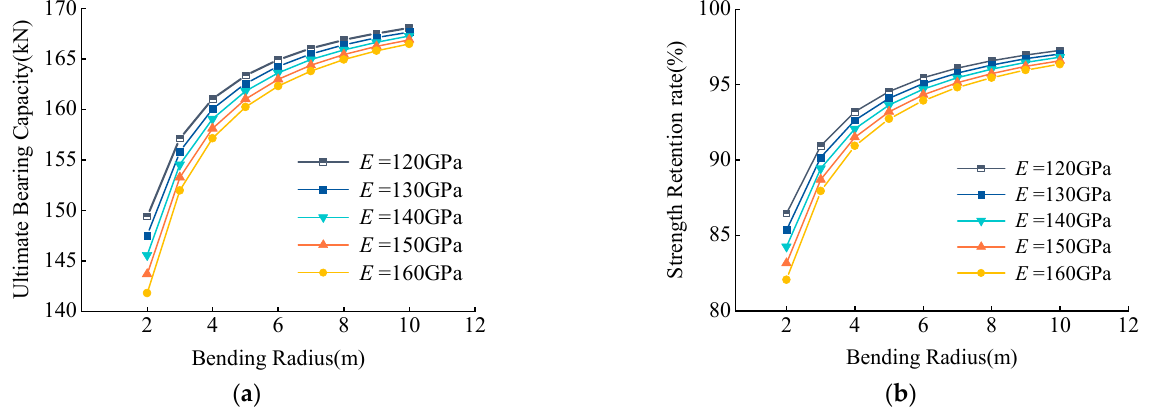
Figure 15. ( a ) Effects of E on UBC, ( b ) Effects of E on RSR. Effects of elastic modulus E on UBC and RSR.